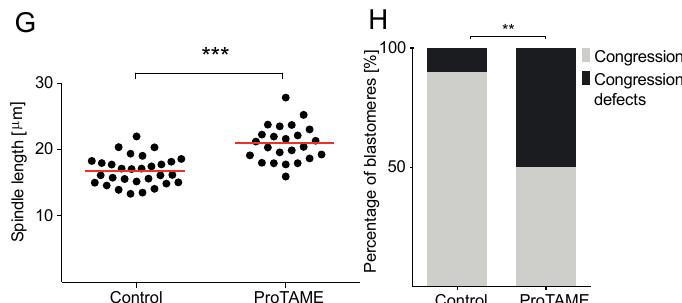
Control ProTAME